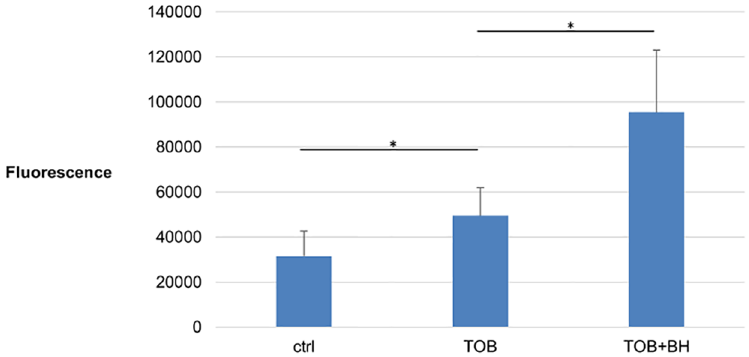
Fig 4. ROS production in B . cenocepacia J2315 biofilms after treatment with TOB alone or in combination with BH. Accumulation of ROS in B . cenocepacia J2315 biofilms, expressed as fluorescence generated after incubation with H 2 DCFDA, after 24 hours treatment with TOB (4 x MIC), TOB in combination with BH (250 μM) or an untreated pH-matched control. Data presented are means, error bars are standard deviations. The experiment was conducted six times. (cid:3) : Significant difference (p < 0.05) compared to treatment with TOB alone.